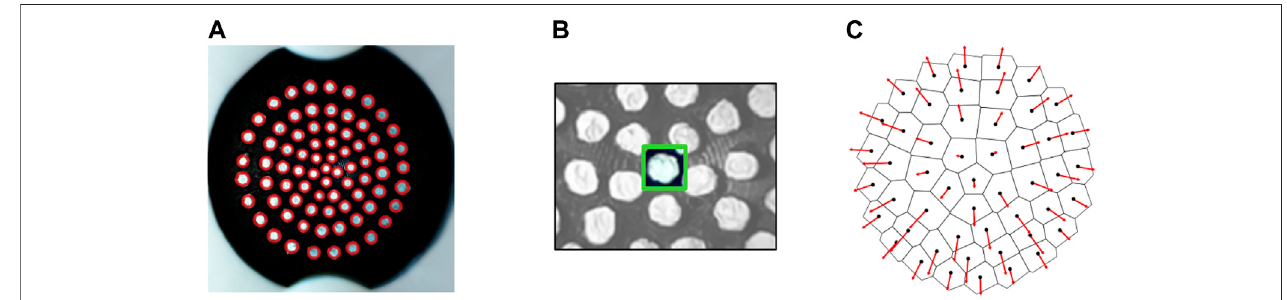
FIGURE 6 | (A) Marker detection with SimpleBlobDetector algorithm tuned to identify white circular blobs against a black background. (B) Individual trackers generated for groups of pixels in a bounding box around each marker and tracked across frames using the TrackerKCF algorithm. (C) Voronoi diagram and marker displacement vectors calculated relative to the undeformed